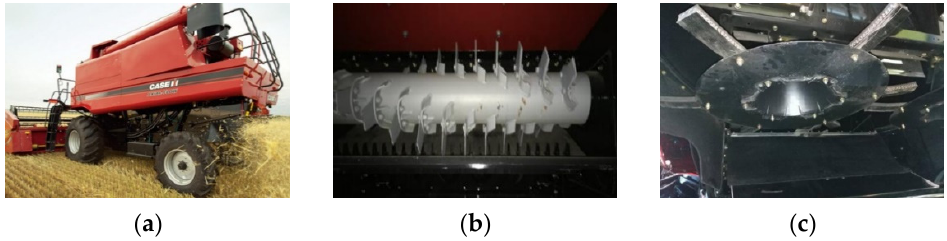
Figure 13. Straw smashing and scattering device of CASE 4000 series axial flow harvesters. ( a ) CASE 4007 combine harvester; ( b ) straw smashing roller; ( c ) scattering device.